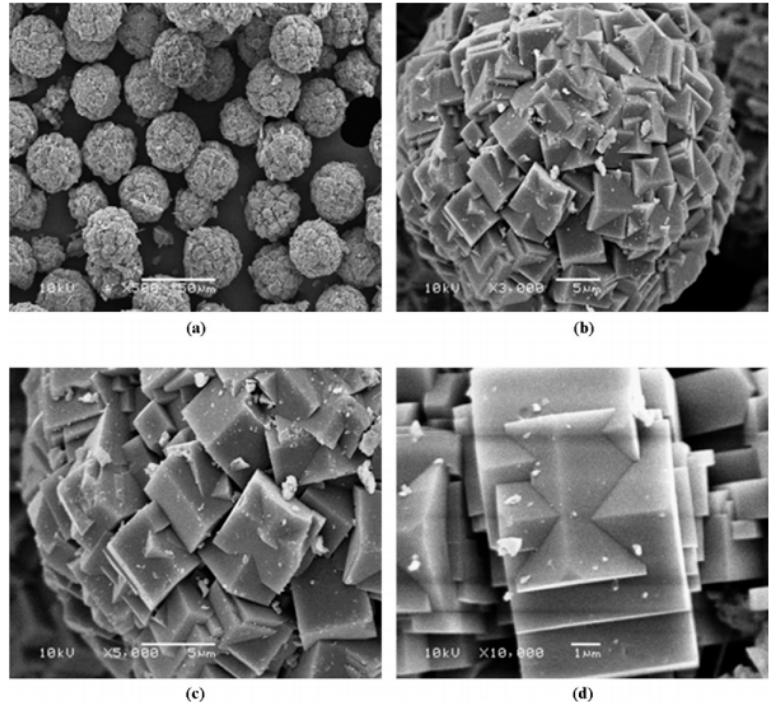
Figure 2. SEM micrographs of the ZSM-5 samples with an Si/Al ratio of 100 and different magnifications: ( a ) 500×, ( b ) 3K×, ( c ) 5K×, and ( d ) 10K× (Reprinted from Applied Catalysis A: General, v. 374, issues 1-2, M. L. Mignoni, M. O. de Souza, S. B. C. Pergher, R. F. de Souza, K. Bernardo-Gusmão,